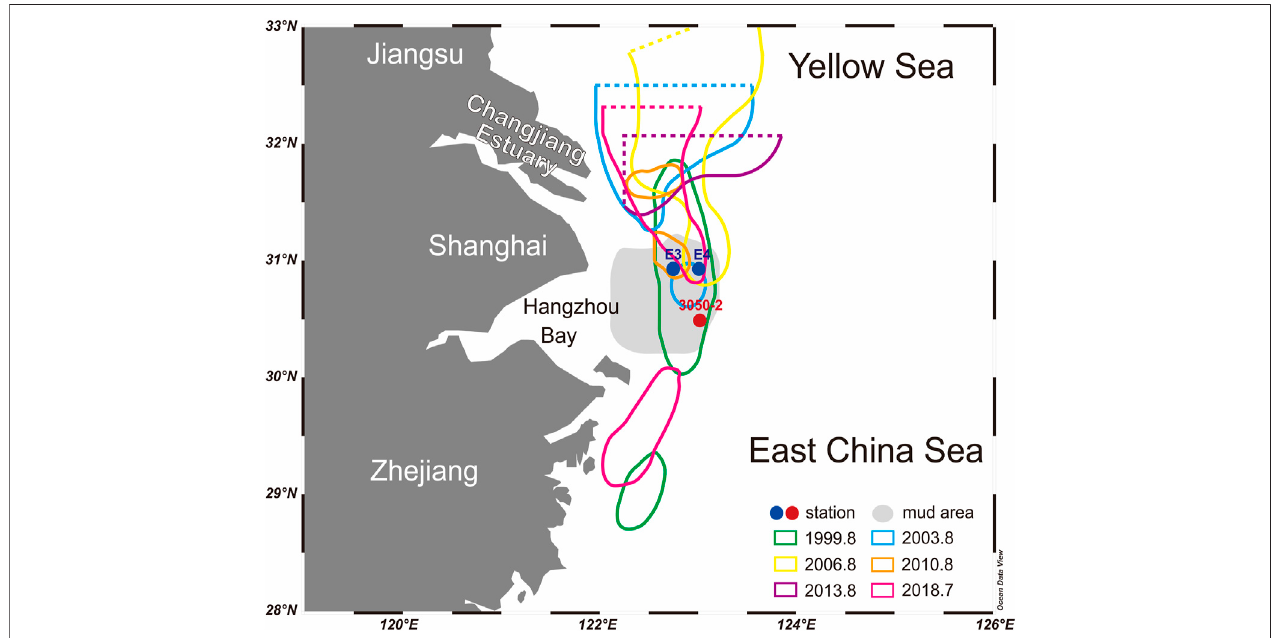
FIGURE 1 | Changes of hypoxic zones near the Changjiang River Estuary and its adjacent waters with locations of core 3,050-2, E3, and E4 (Wu et al., 2020; Yin et al., 2020). Areas marked by solid and dotted lines in different colors were hypoxic zones (DO ≤ 2.0 mg/L) recorded in recent years. The details of these stations are given in Supplementary Table S1